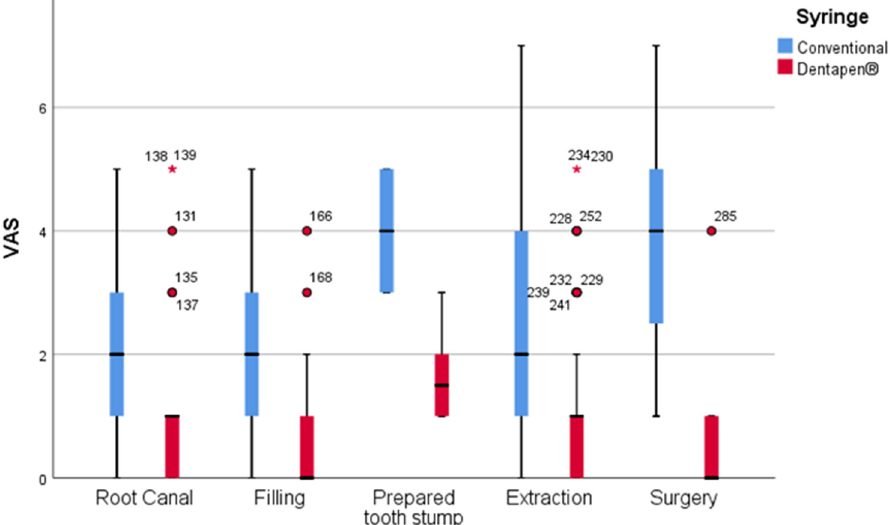
Figure 1. BOX-PLOT VAS (visual analogue scale) based on the type of treatment and the type of syringe used. Table 3. VAS comparison and statistical significance based on the area of